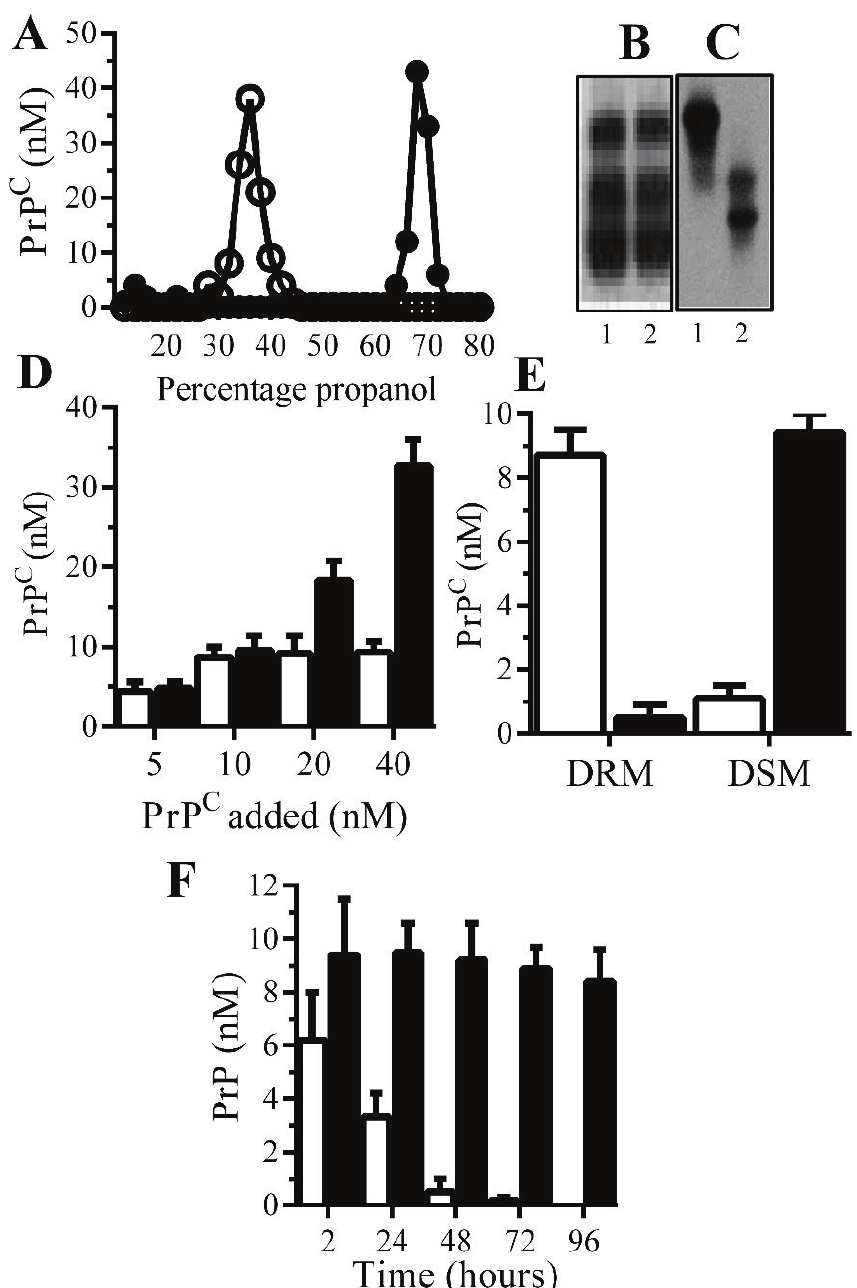
Figure 1. Monoacylated PrP C is expressed in neurons: ( A ) The concentrations of PrP C (●) or monoacylated PrP C (○) in fractions eluted from C18 columns. Values are means of duplicates; PrP C (1) and monoacylated PrP C (2) separated by PAGE ( B ) or HPTLC ( C ). ( D ) The concentrations of PrP C in Prnp (0/0) neurons treated with PrP C (□) and monoacylated PrP C (■) , as shown for 2 h. Values are means ± SD from triplicate experiments performed four times ( n = 12). ( E ) The concentrations of PrP C (□) and monoacylated PrP C (■) in DRM (rafts) or DSMs in Prnp (0/0) neurons pulsed with 10 nM PrP C preparations for 2 h. Values are means ± SD from triplicate experiments performed four times ( n = 12). ( F ) The concentrations of PrP C (□) and monoacylated PrP C (■) in Prnp (0/0) neurons at different time periods after being pulsed with 10 nM PrP C preparations. Values are means ± SD from triplicate experiments performed four times ( n =